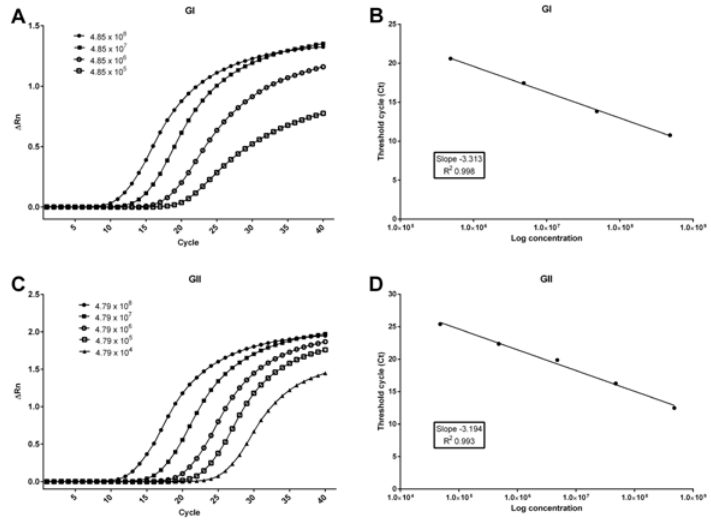
Figure 4. One-step SYBR s Green real-time RT-PCR assay for norovirus (NoV) GI ( A and B ) and GII ( C and D ). The linearity of the assay was determined using a serially 10-fold diluted NoV RNA transcribed from plasmids containing either the NoV GI ( A ) or GII ( C ) targeted region. B and D , Standard curves generated from ampli fi cation of NoV GI and GII by real-time RT-PCR.